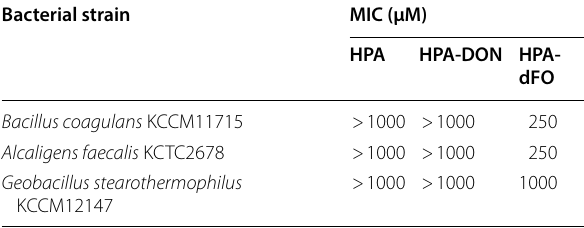
MIC (Minimum Inhibitory Concentration) was calculated by 80% growth inhibition of control bacterial growth